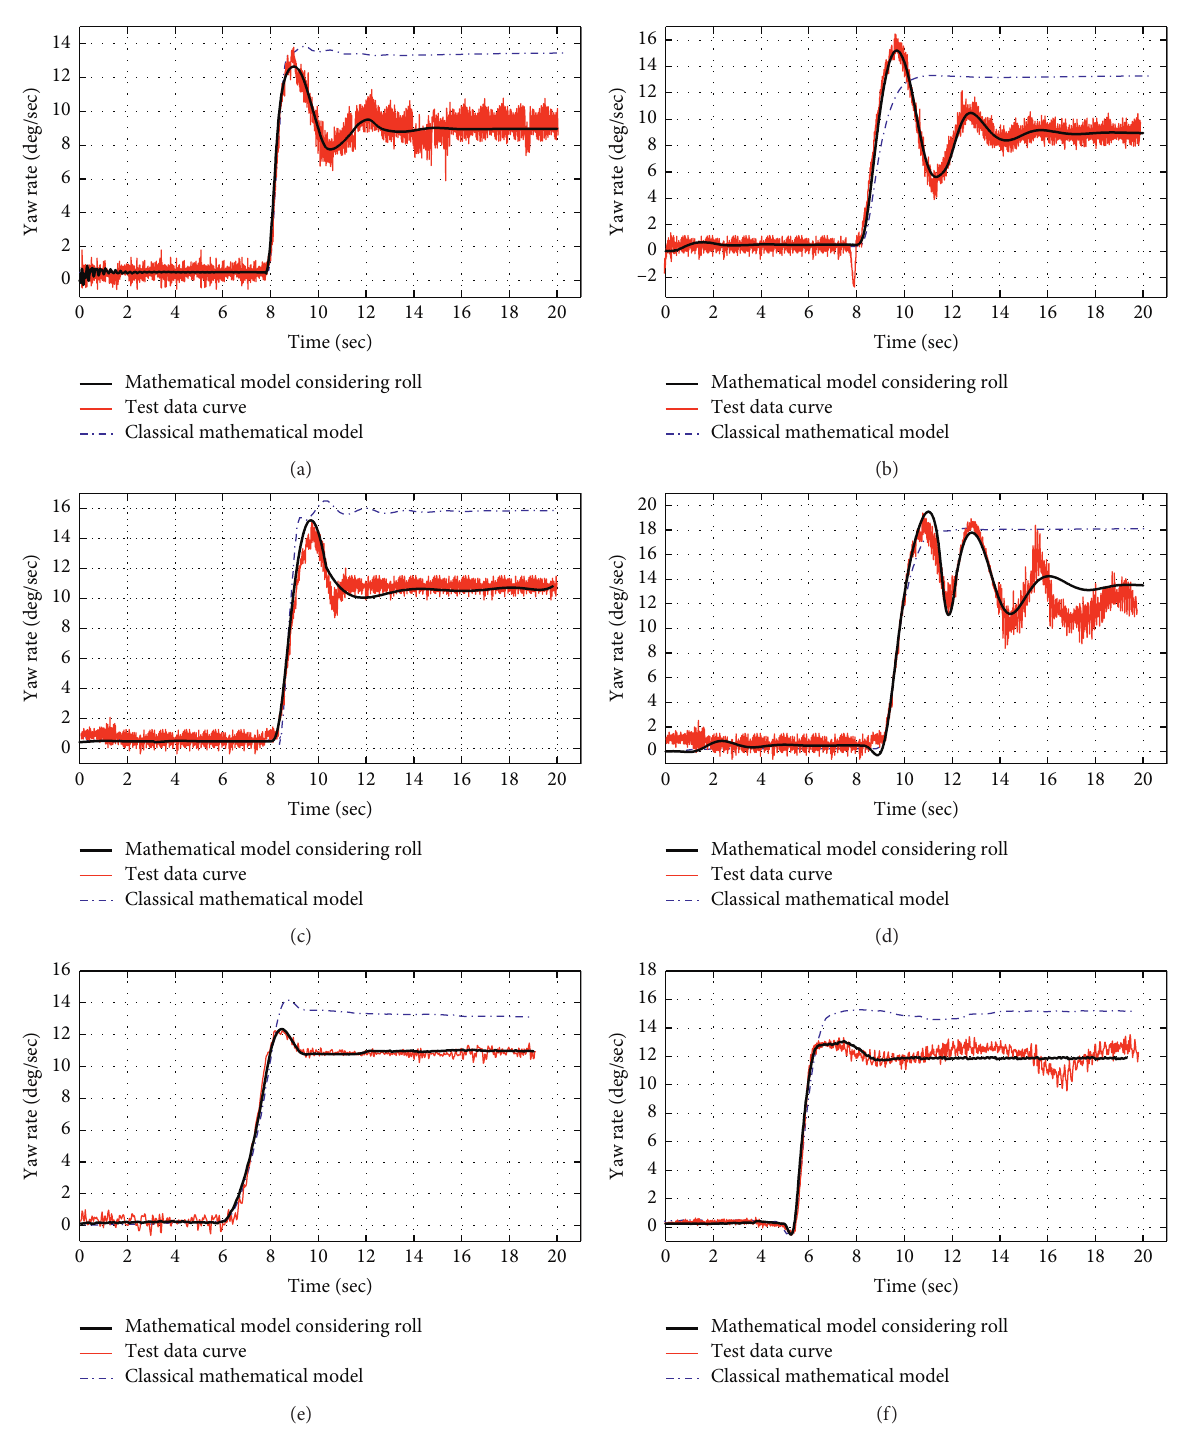
Figure 6: Comparison of the simulation and experimental test curves for the three different types of semitrailer. (a, b) Yaw rates of the tractor and trailer of semitrailer I, respectively. (c, d) Yaw rates of the tractor and trailer of semitrailer II, respectively. (e, f) Yaw rates of the tractor and trailer of semitrailer III,